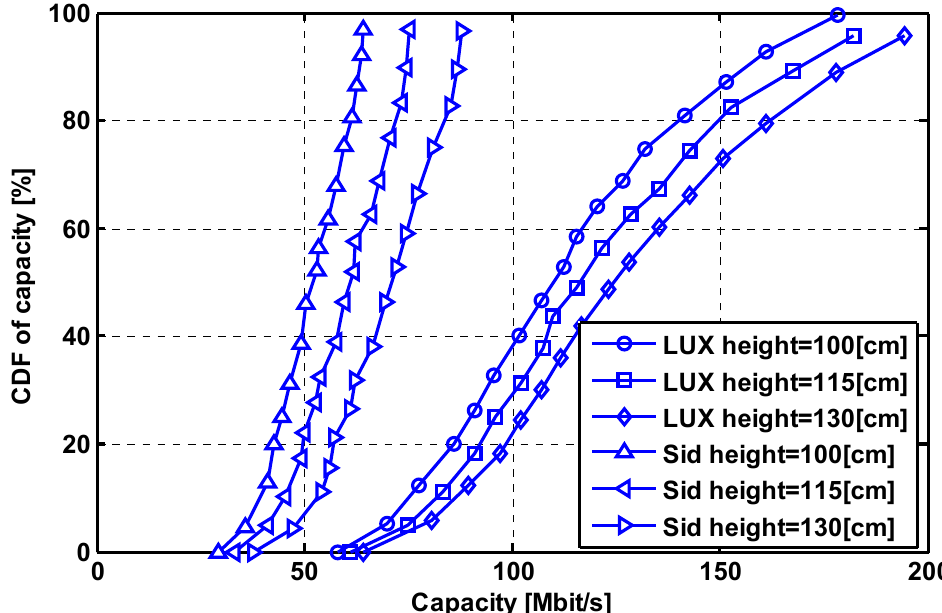
Figure 7. Comparison of the MIMO capacity CDF under different receiver height.